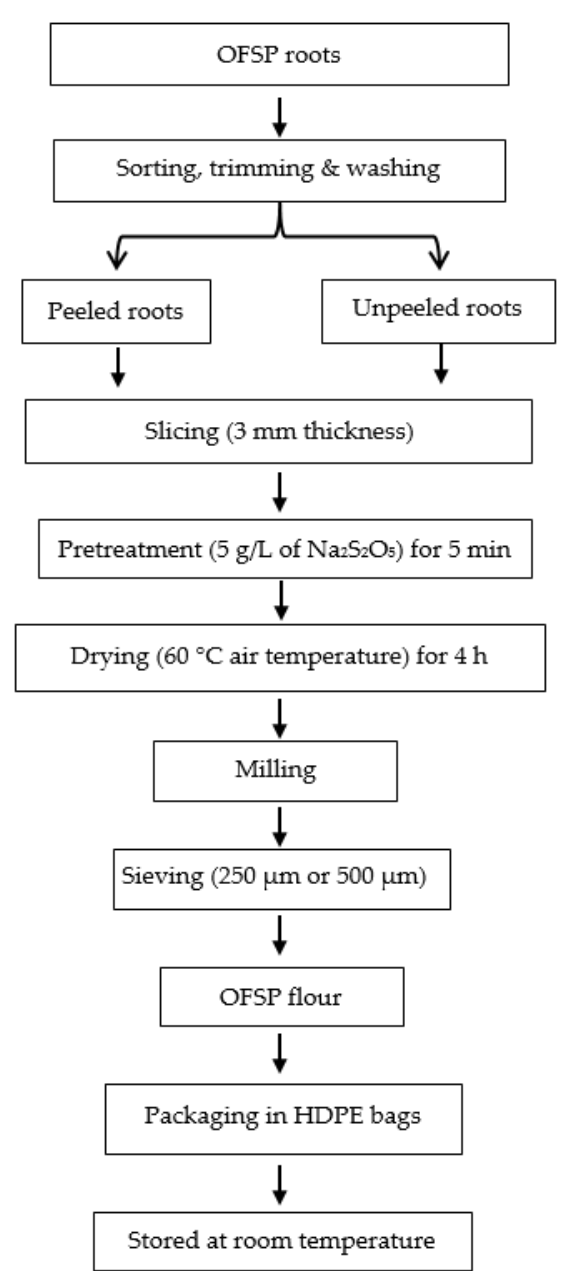
Figure 1. Flow chart for processing peeled and unpeeled orange fleshed sweet potato (OFSP) flours. HDPE represent high density polyethylene.